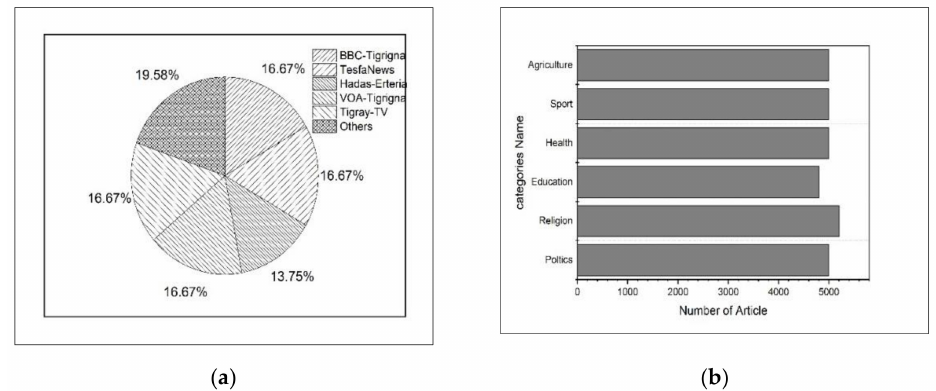
Figure 3. ( a ) Corpus website sources; ( b ) Number of articles per categories.